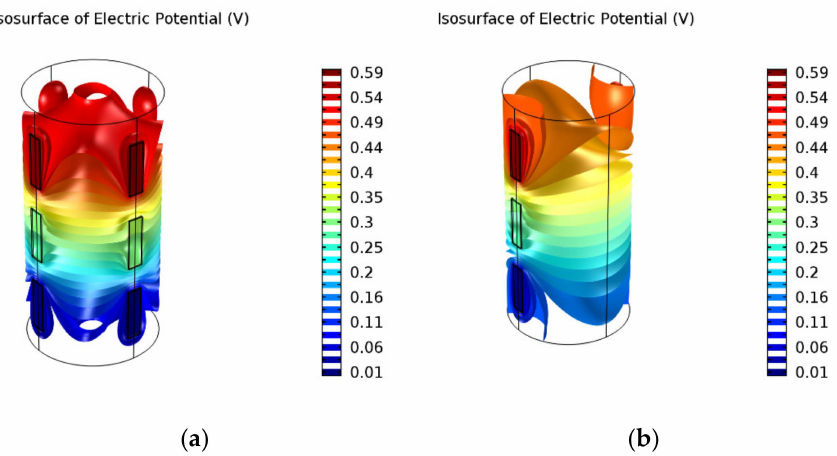
Figure 4. Resulting iso-surfaces, calculated by Comsol, for angular distances of the electrodes of 90 ◦ ( a ) 180 ◦ ( b